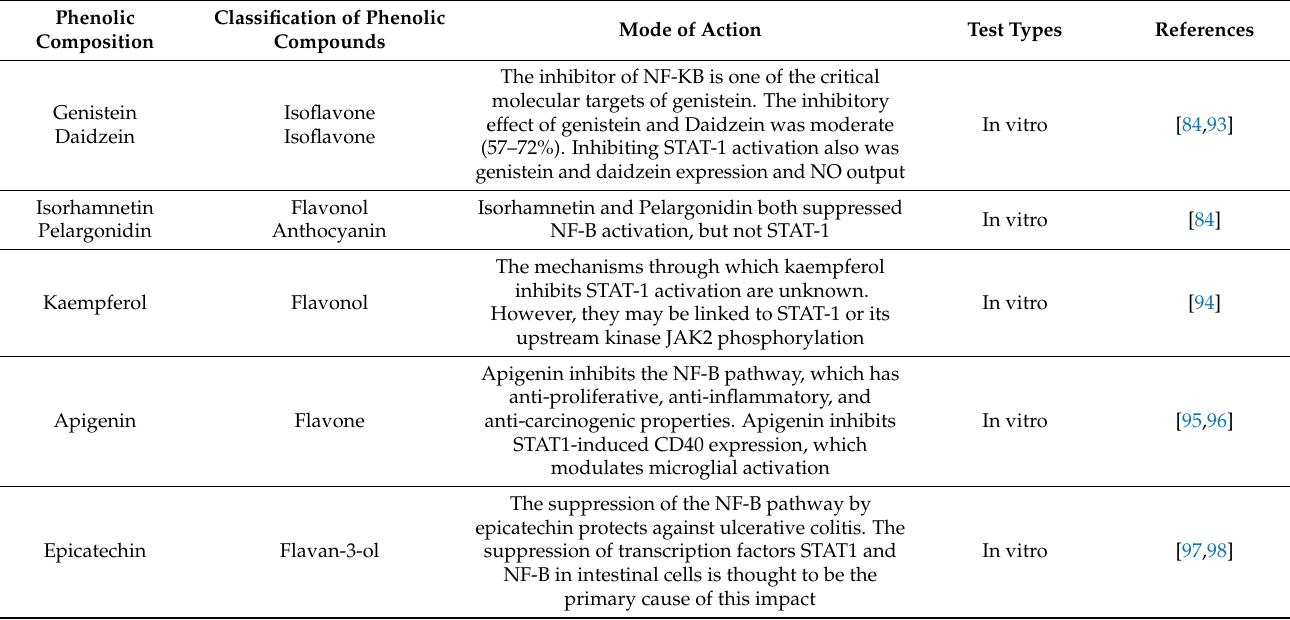
Table 1. Mechanisms of anti-inflammatory activity mediated by dietary phenolic compounds [76].